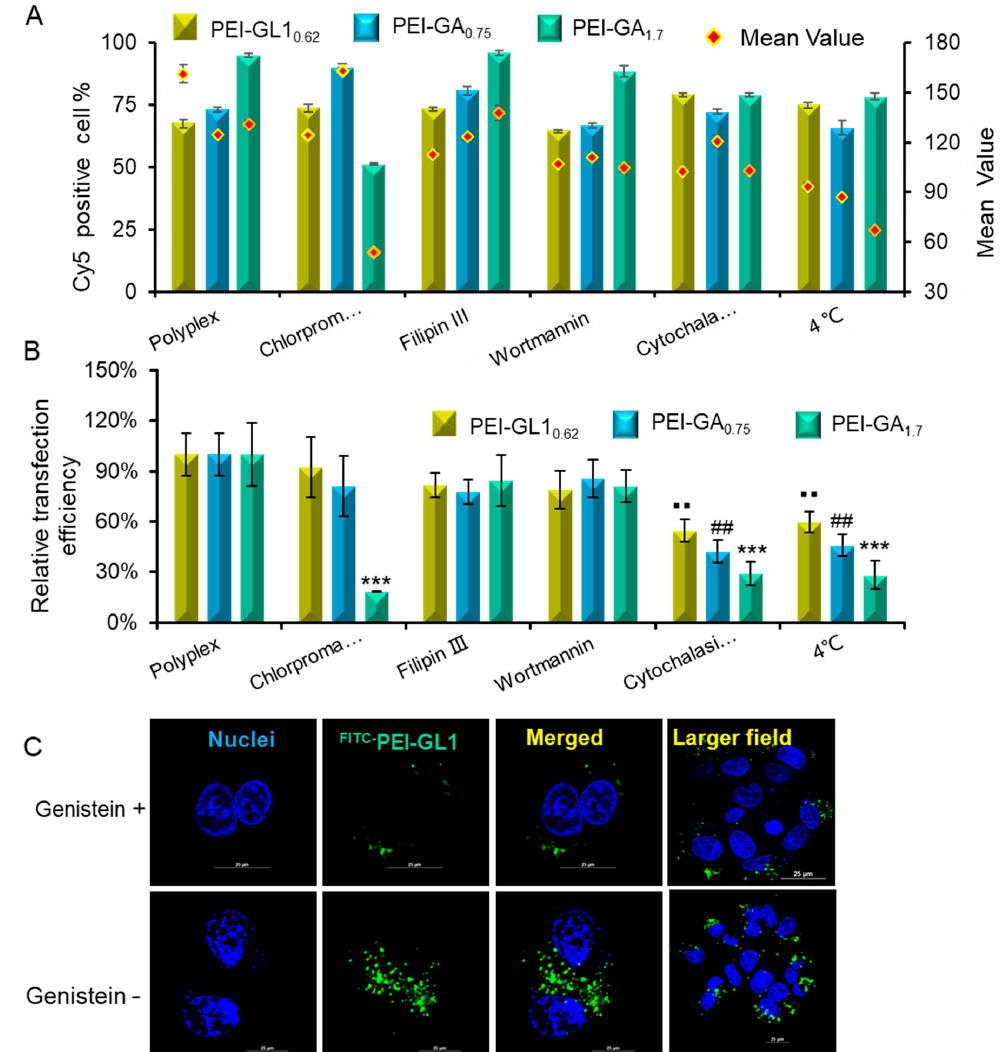
Figure 7. Endocytosis inhibitor e ff ects on cellular uptake ( A , C ) and transfection e ffi ciency ( B ). ( A ) Cy5-positive HepG2 cells measured by flow cytometry after pretreatment of the cells with four inhibitors (Chlorpromazine, Filipin III, Cytochalasin D and Wortmannin) for 0.5 h and then cultured with the three polyplexes for 2 h in serum-free medium at 37 ◦ C or 4 ◦ C. ( B ) The e ff ect of the four inhibitors on transfection e ffi ciency of the three polyplexes in HepG2 cell after 48 h at 37 ◦ C or 4 ◦ C. The results are shown as mean ± SD ( n = 3). Statistically significant di ff erences are indicated by ** ( ## , (cid:4)(cid:4) ) p < 0.01 and *** p < 0.001 using t-test, compared to polyplex. ( C ) The e ff ect of Genistein on cell phagocytosis observed by confocal laser scanning microscopy after 2 h post-transfection. The cell nuclei were stained with Hoechst 33342 (blue). Polyplexes labeled with FITC (See Supporting Information for details) were shown in green. All scale bars represent 25 µ